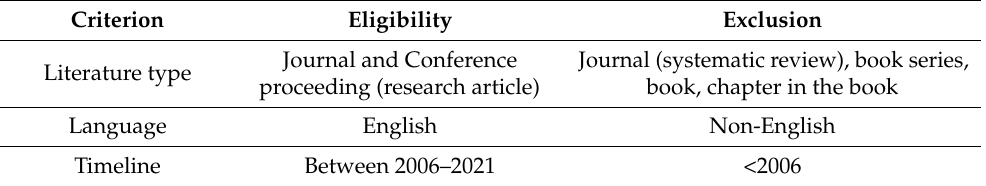
Table 2. Inclusion and exclusion